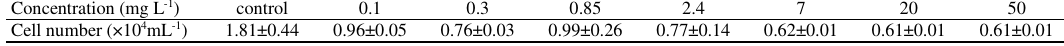
Concentration (mg L -1 )